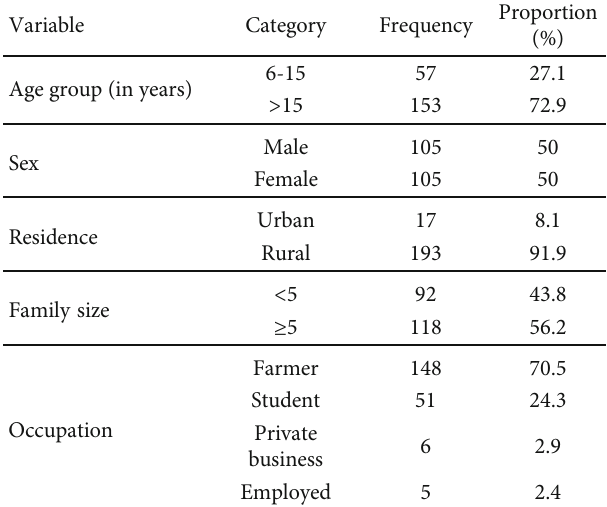
Table 1: Sociodemographic characteristics of ( N = 210 ) of study participants attending Hamusit Health Center, Northwest Ethiopia, from February to March